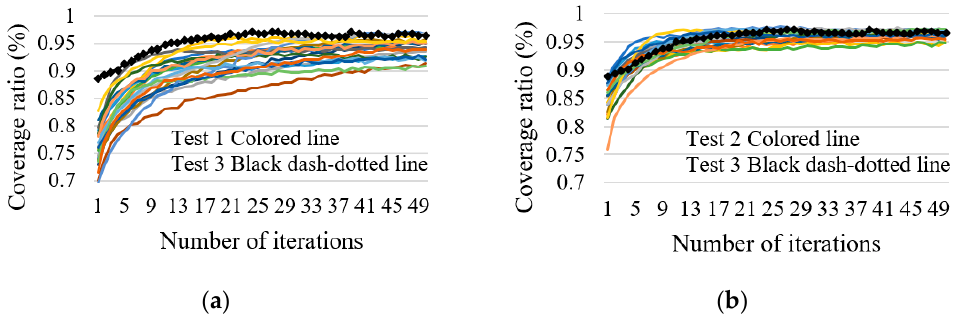
Figure 9. For ease of observation, two figures are used to show the comparison of the three experiments in the relationship between coverage ratio and number of iterations. The comparison between Tests 1 and 3 is shown in ( a ), and the comparison between Tests 2 and 3 is shown in ( b ).